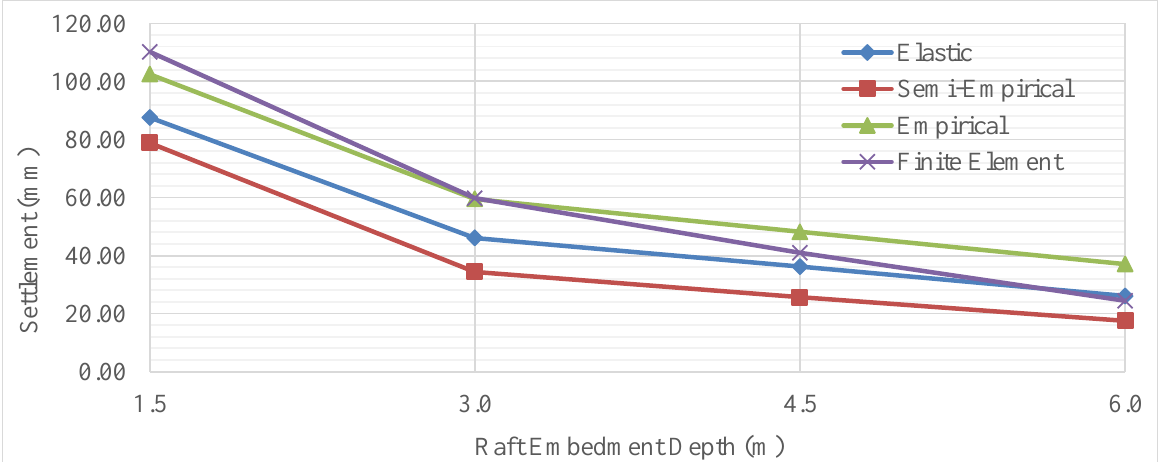
Fig. 8. Settlement versus embedment depth for 400 kN/m 2 applied pressure.